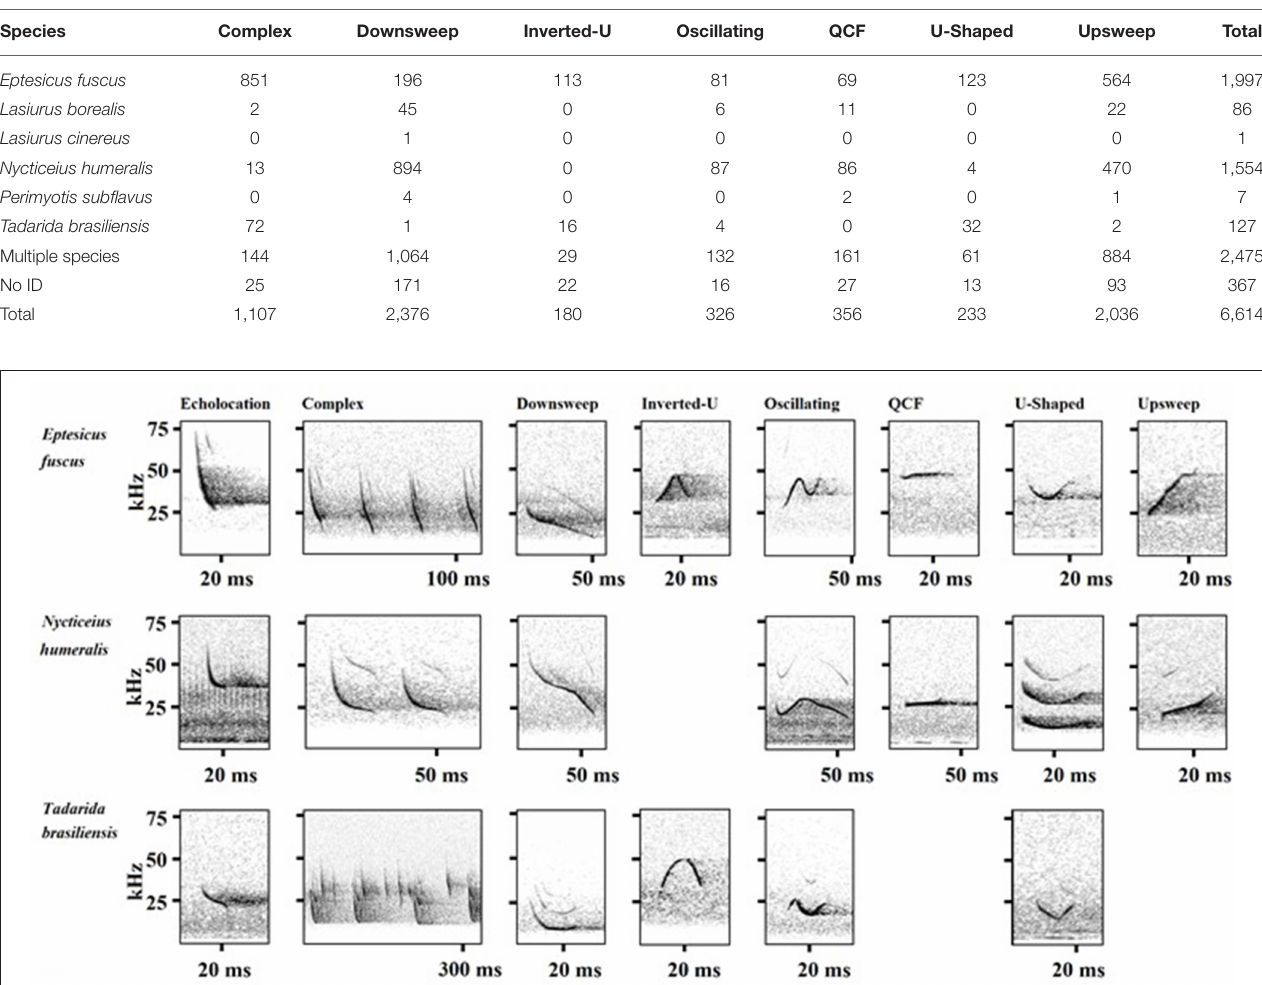
Figure 1 ). Eptesicus fuscus complex calls consisted of multiple similar downsweeps, while the individual pulses of T. brasiliensis complex calls were downsweeps, u-shaped, or oscillating pulses. The DFA agreed with manual classification for 100% of